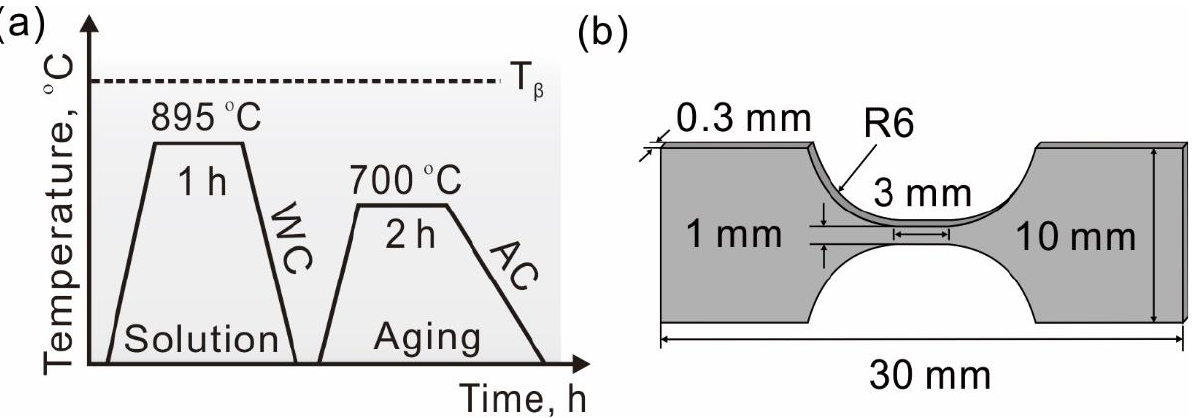
Figure 1. Schematic illustrations of ( a ) the process of heat treatment and ( b ) tensile specimen.